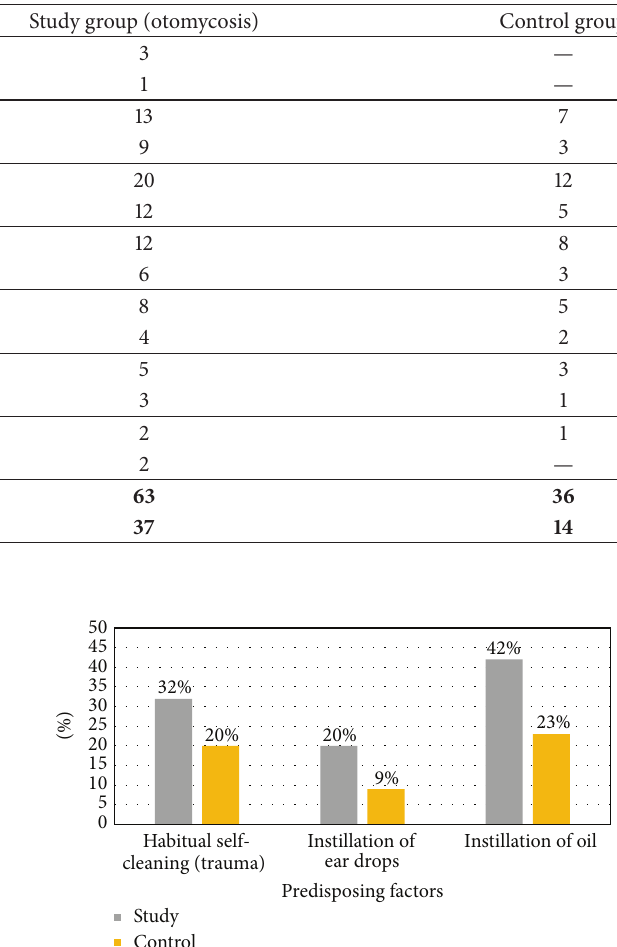
Table 1: Demographic profile of the subjects in the study (otomycosis) and control groups.